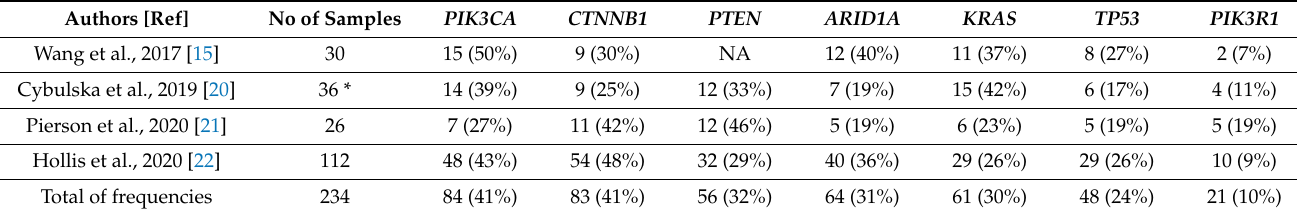
Table 2. Frequency of somatic gene alterations in ovarian endometrioid